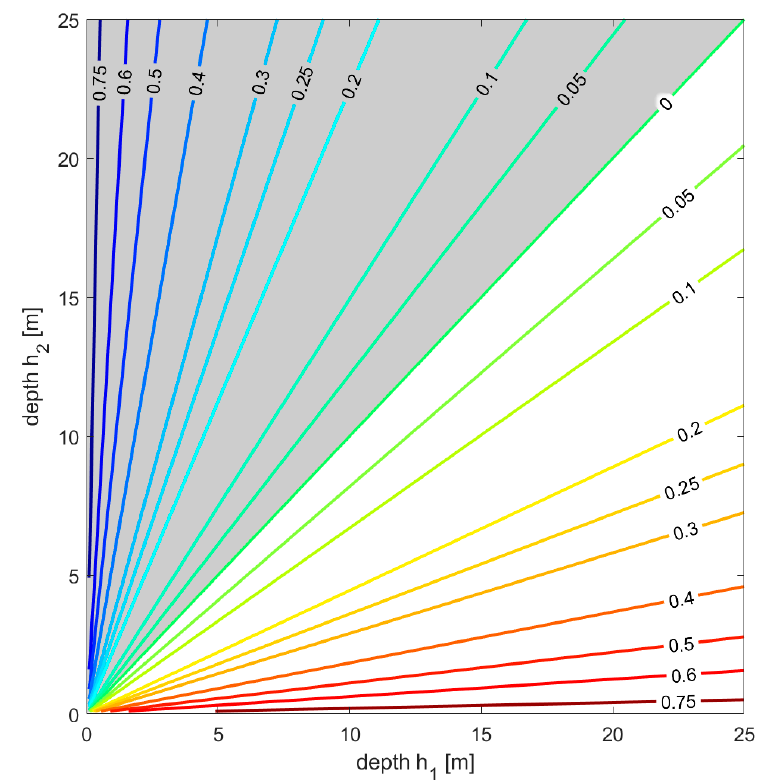
Figure 3. Visualization of the reflection coefficient at abrupt bathymetric changes for different depths and constant widths upstream and downstream of the bathymetric change. The gray shaded area indicates reflection with a phase jump of 180°.